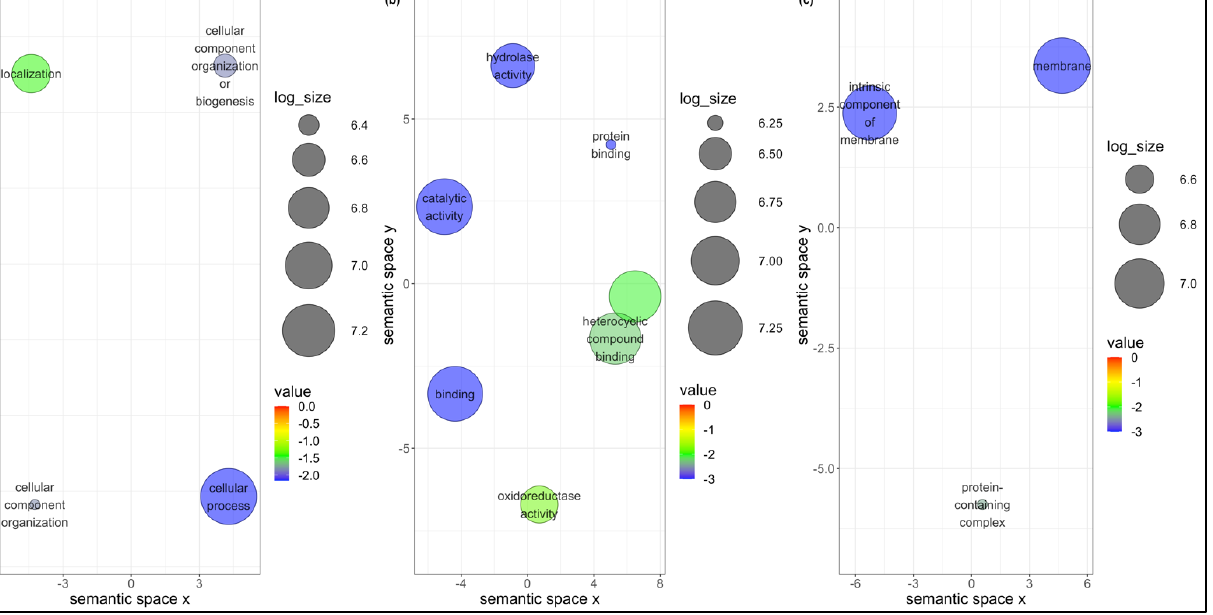
Figure 5. Scatterplots showing ( a ) biological process, ( b ) molecular function, and ( c ) cellular com- ponent gene ontology terms for Bemisia tabaci Mediterranean following the acquisition of viruses. Cluster representatives in a two-dimensional space were derived by applying multidimensional s caling to a matrix of the gene ontology terms’ semantic similarities. Bubble color indicates the p- value, and size indicates the frequency of the GO term in the underlying GOA database.